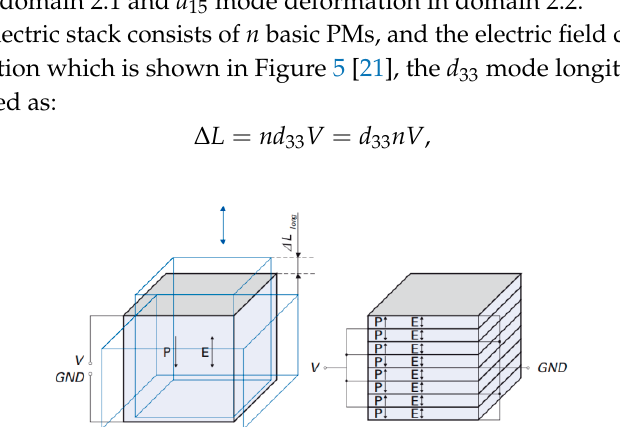
Figure 5. The principle of longitudinal deformation caused by the d 33 mode.